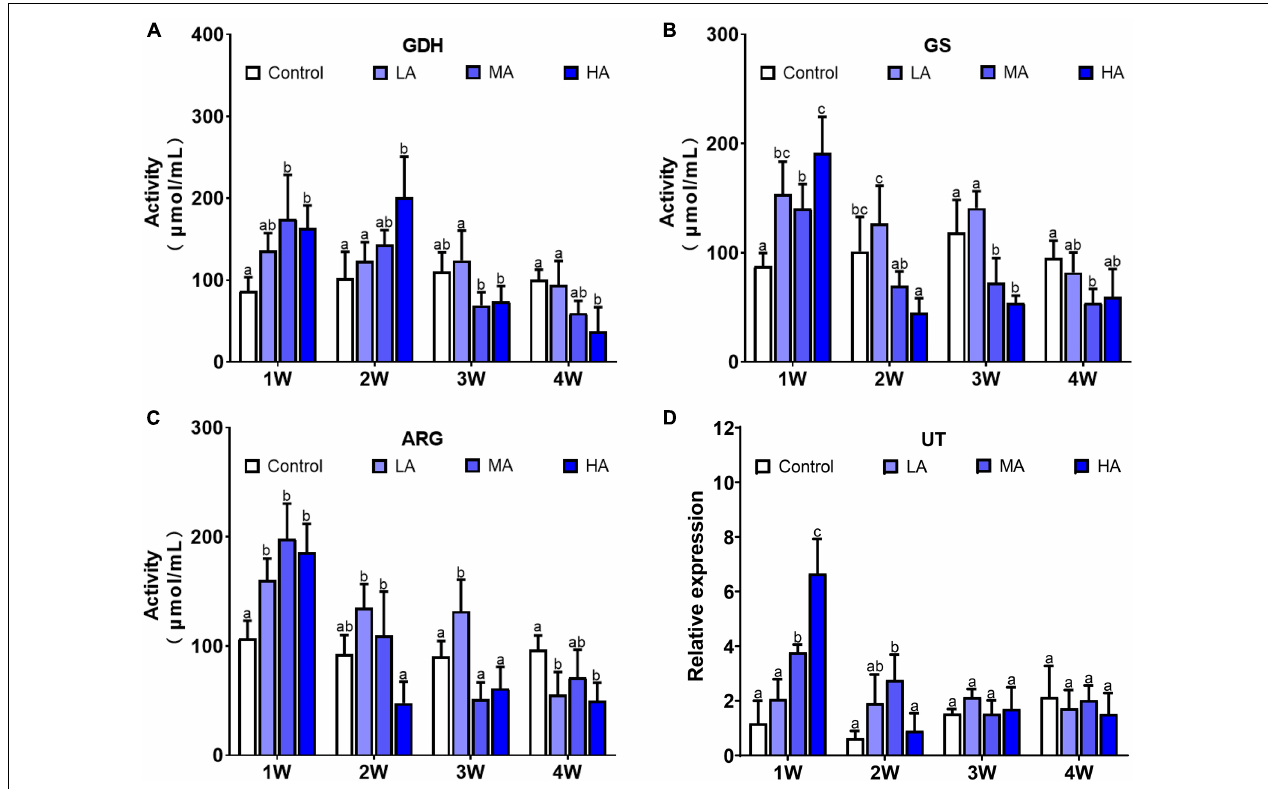
FIGURE 3 | Activities of GDH (A) , GS (B) , ARG (C) , and expression of UT (D) in different treatments during long-term ammonia stress. Values are means ± S.D ( n = 3). Different letters represent significant differences among different groups ( P <